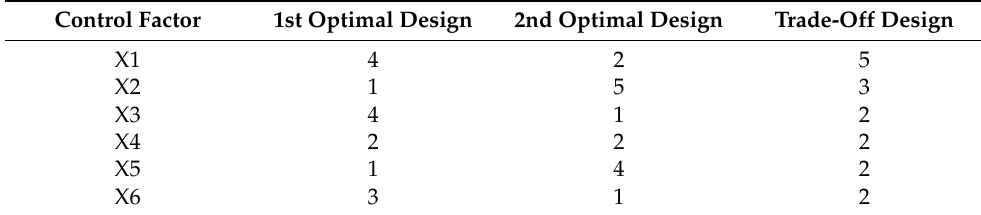
Table 4. Optimal designs according to the Taguchi